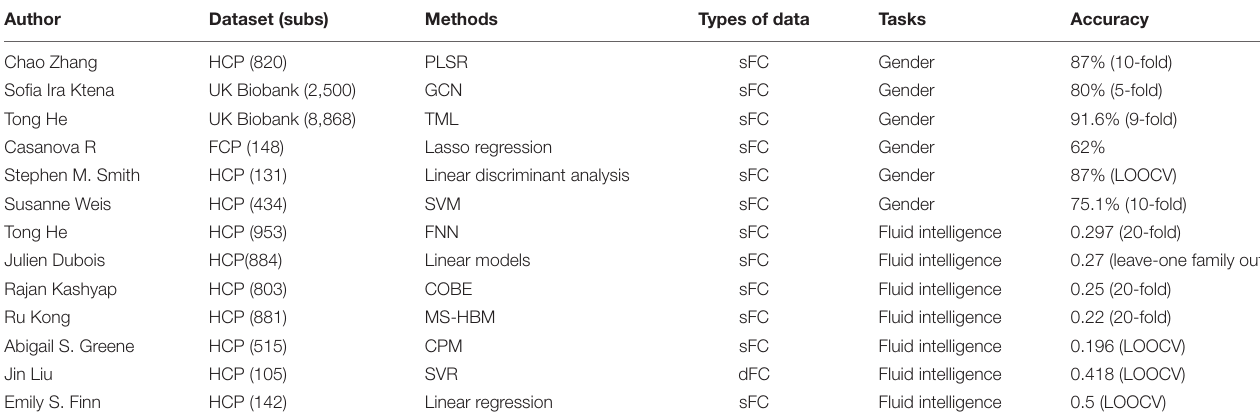
TABLE 1 | Model performance of rs-fMRI based gender classification and intelligence prediction tasks in some recent studies.